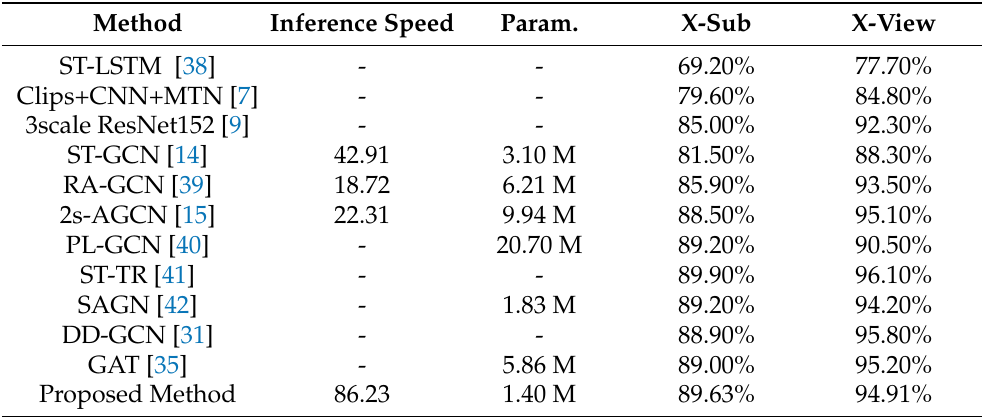
Table 1. Accuracy comparisons with mainstream methods on NTU-RGB+D 60 dataset. Inference speed (sequences/(second ×